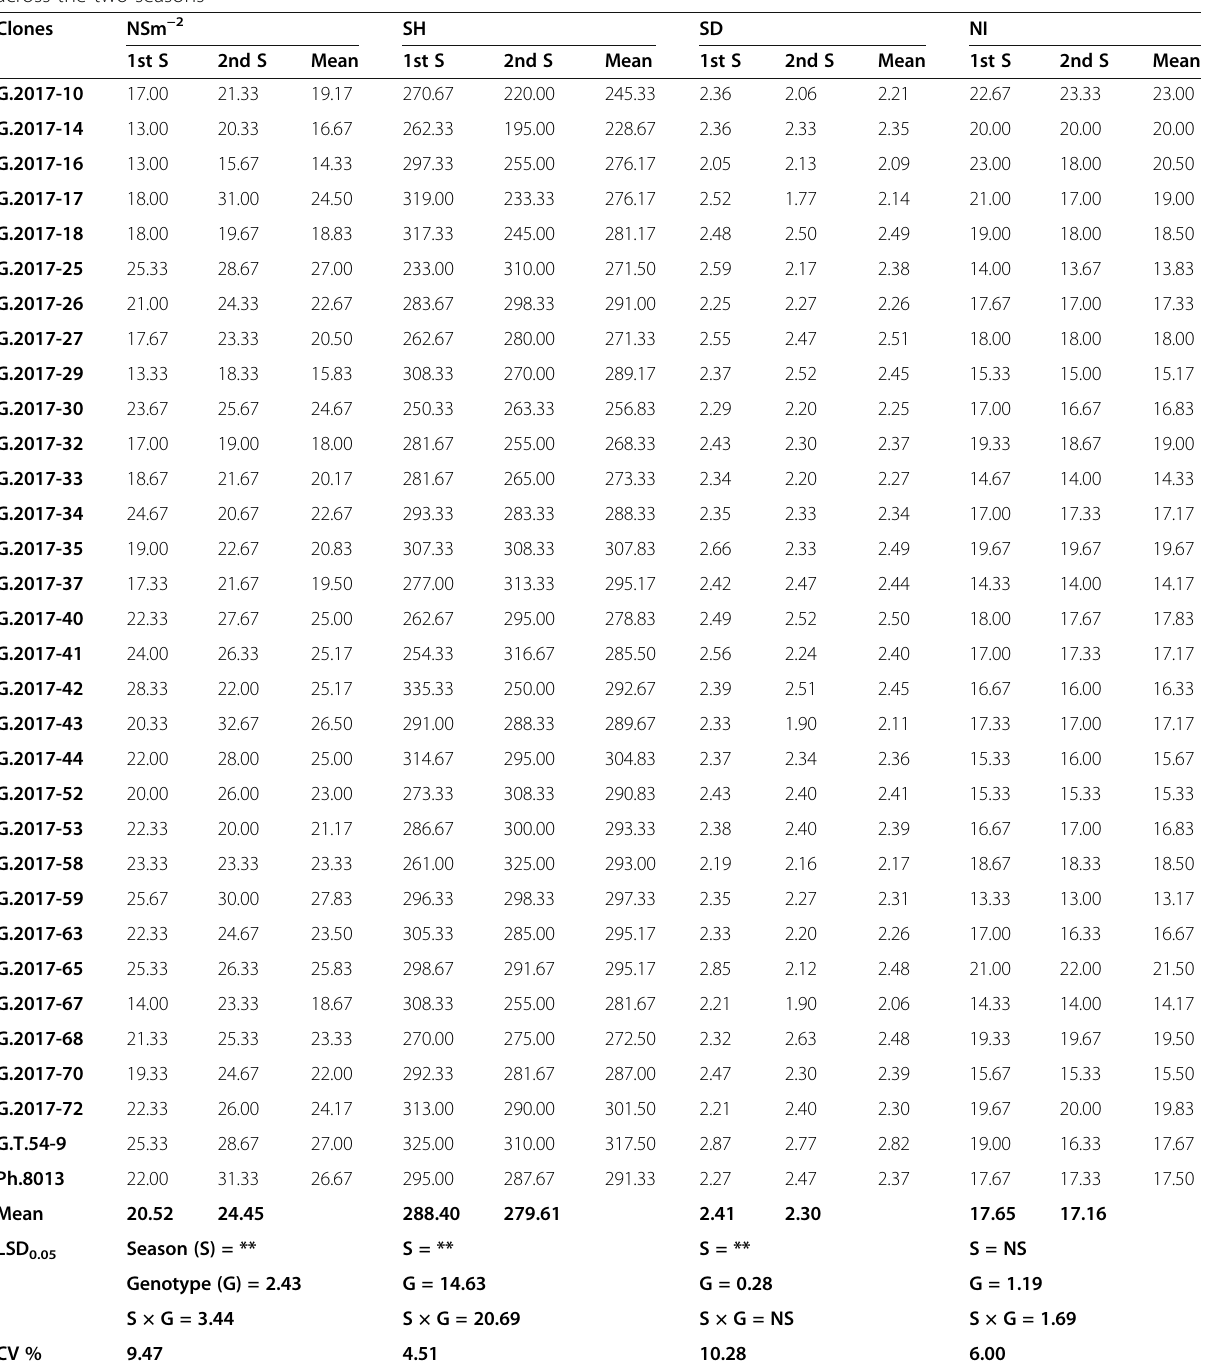
Table 3 Mean performance of 30 sugarcane genotypes and two check cultivars for growth characters in the first, second, and across the two seasons Clones NSm − 2